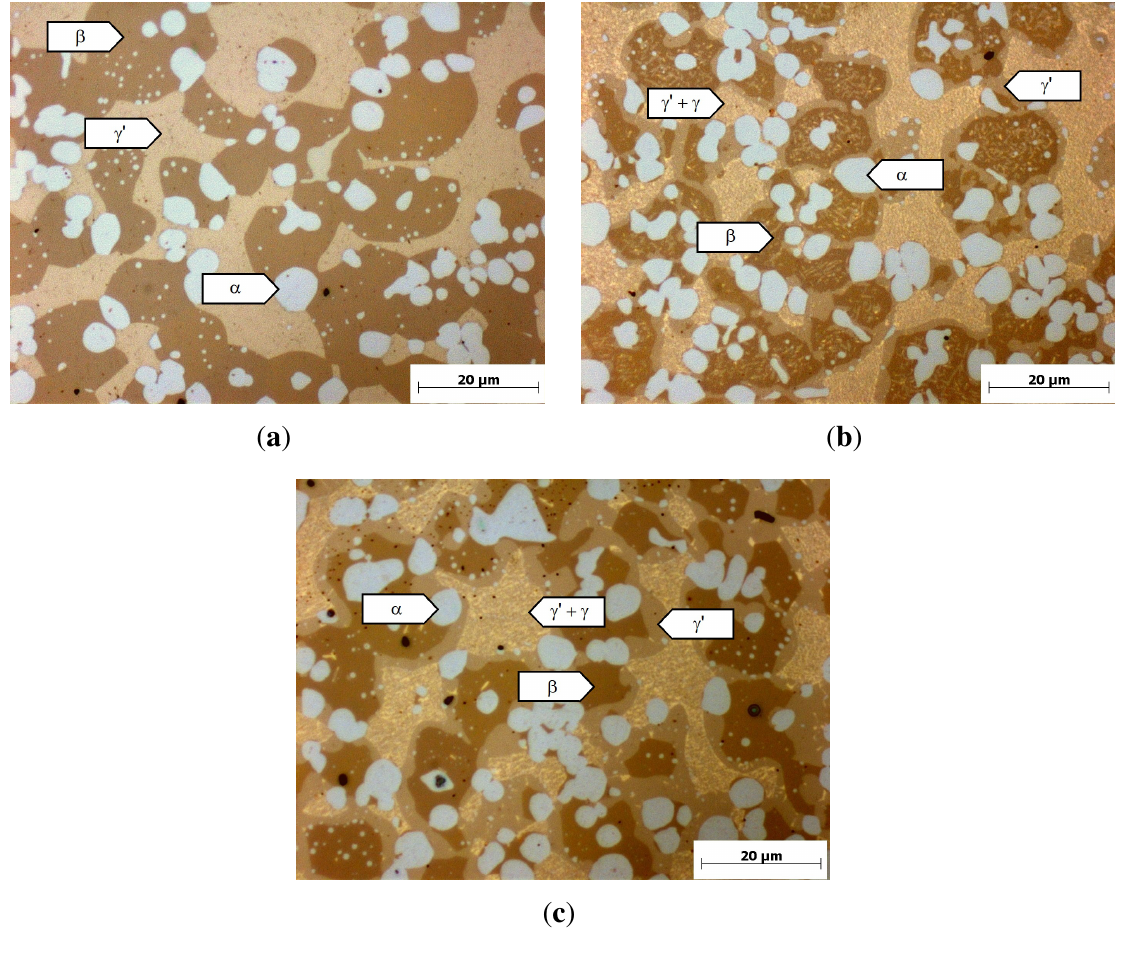
Figure 5. Optical micrograph of the alloy Ni-30%Cu-22%Cr-10%Al after different heat treatments, not etched. ( a ) Homogenization (1000 ◦ C, 4 h); ( b ) 800 ◦ C,4 h; ( c ) 800 ◦ C, 100 h.